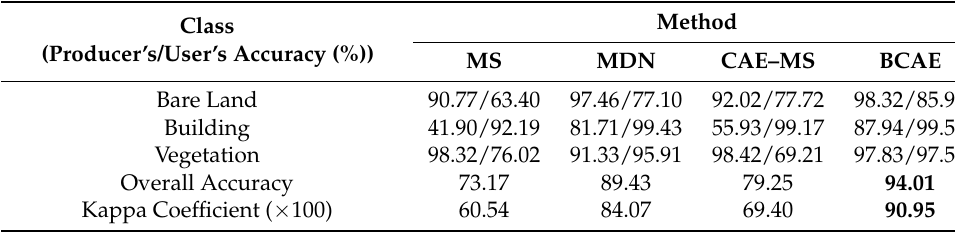
Figure 3. Clustering maps of Tunis dataset. ( a ) The true color composite, ( b ) the ground truth map, ( c ) MS, ( d ) MDN, ( e ) CAE – MS, and ( f ) BCAE. Table 9. A comparison between the clustering results of the Tunis